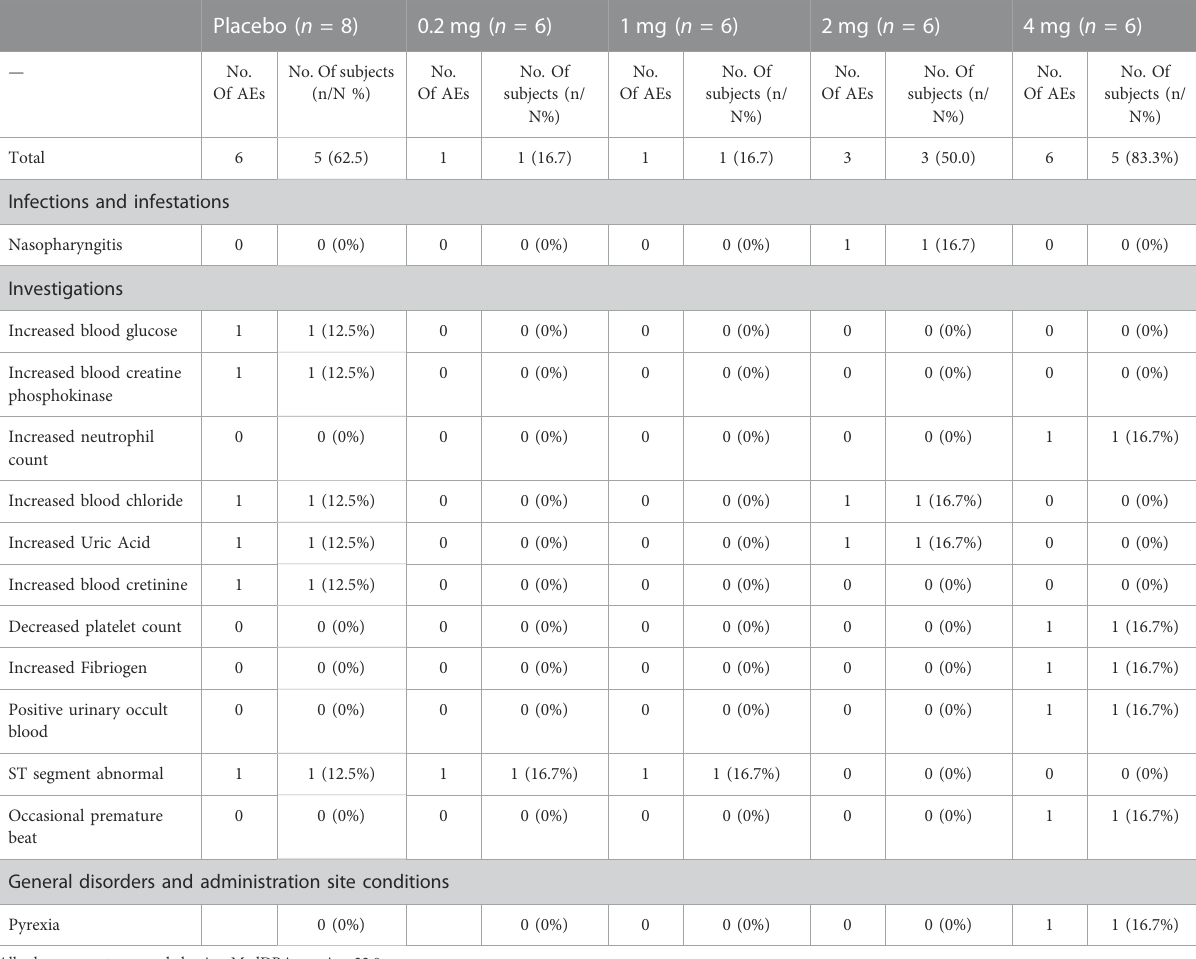
TABLE 3 Incidence of adverse events by system organ